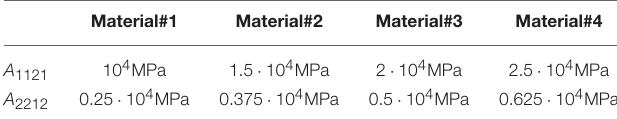
TABLE 2 | Mechanical properties used in Configuration 1 .